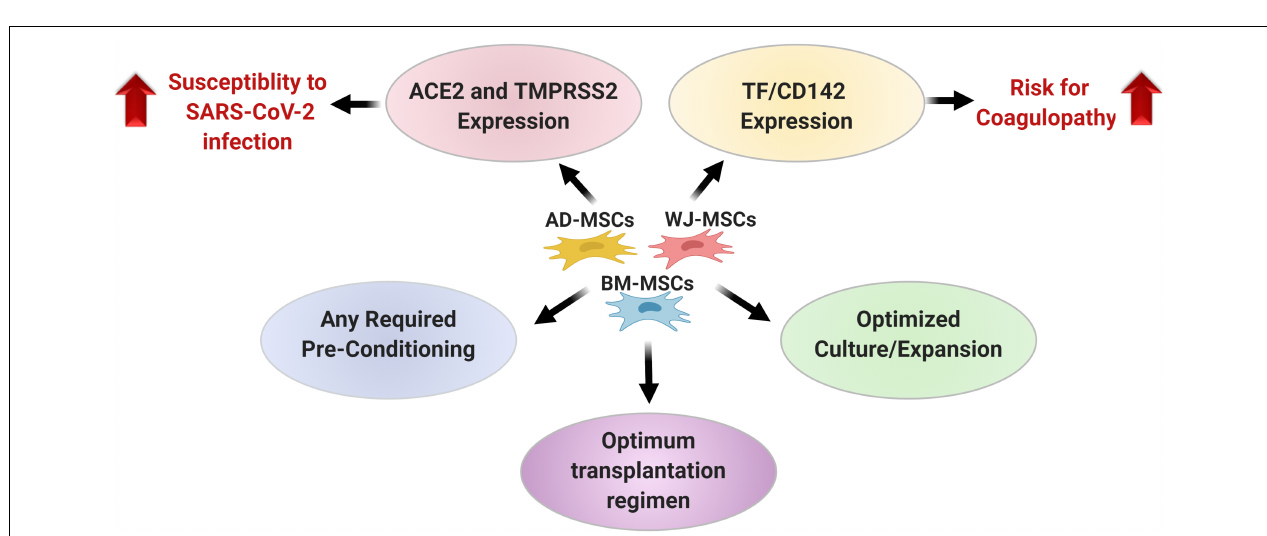
FIGURE 2 | A summary for the critical issues that should be carefully considered when selecting a certain type of mesenchymal stem cells for COVID-19 treatment. AD, Adipose tissue; ACE2, Angiotensin converting enzyme; BM, Bone marrow; COVID-19, Corona Virus Disease-2019; MSCs, Mesenchymal Stem